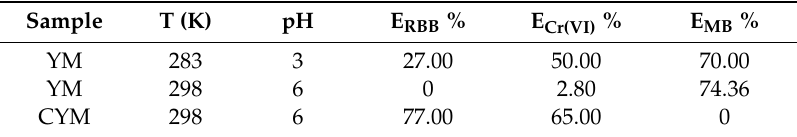
Table 4. Removal e ffi ciency of MB, Remazol brilliant blue (RBB) and chromium hexavalent Cr(VI) on YM and CYM